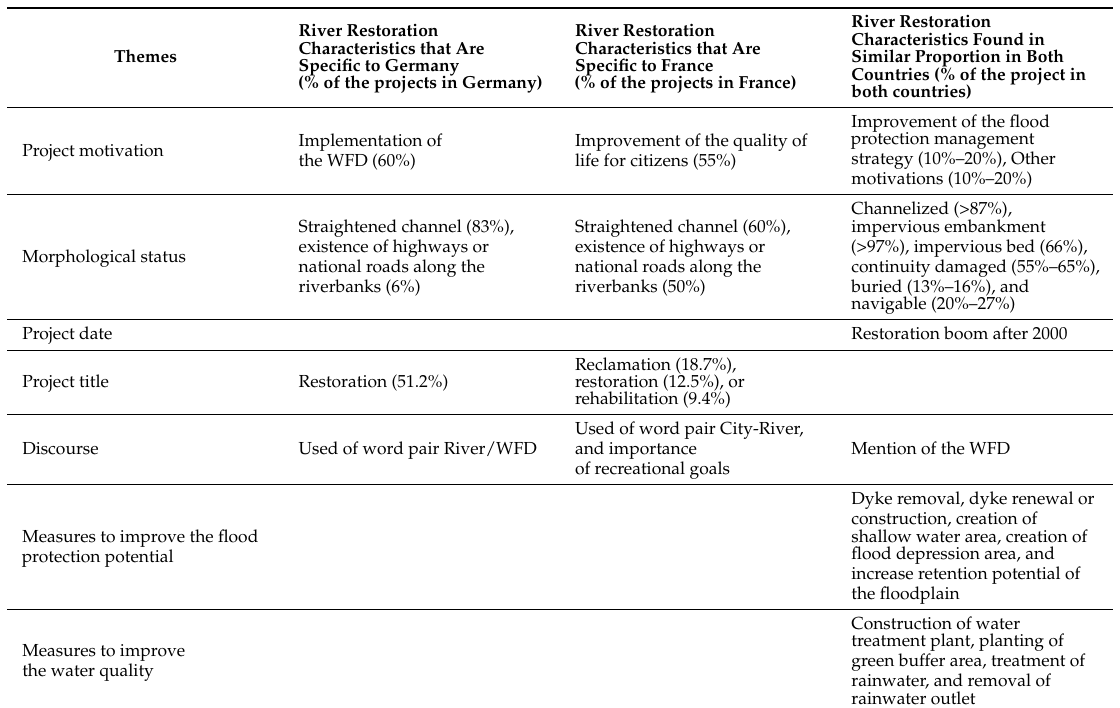
Table 2. Synthesis of the differences and similarities between urban river restorations in France and